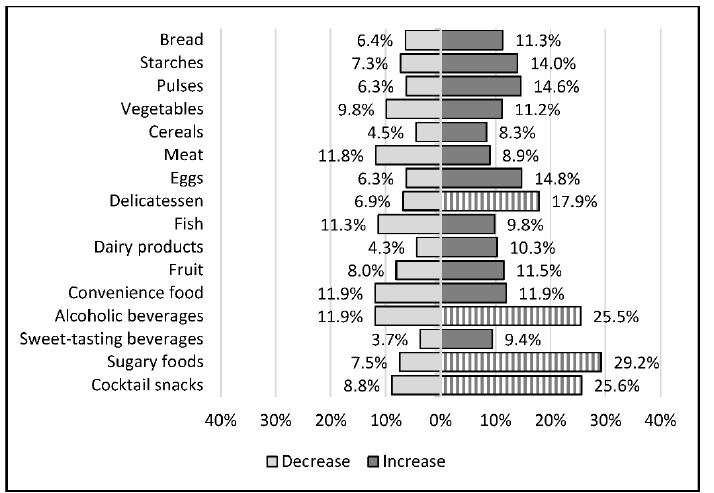
Figure 2. Modifications in the consumption of major food groups during the first lockdown (between 17 March and 10 May 2020). Bars indicate the percentage of participants who reported having increased or decreased their consumption of the food group during lockdown (corresponding number shown on the respective bars). Hatched bars represent percentage above 15%.